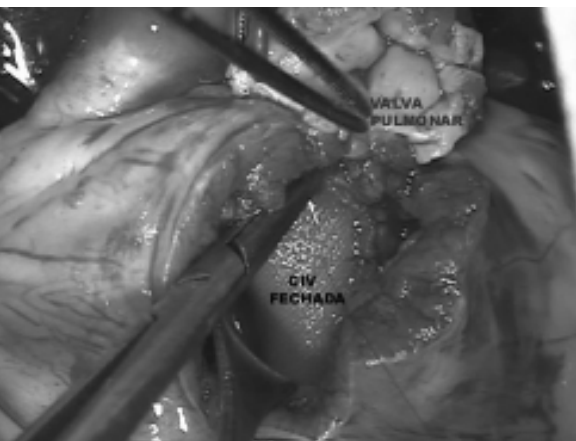
in the right ventricle outflow tract